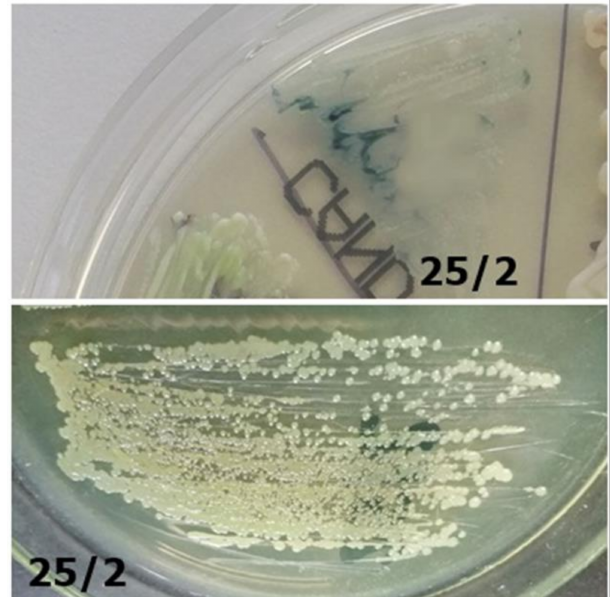
Figure 7. Strain 25/2-morphology on CHROMagar Candida and Sabouraud 2 with chloramphenicol medium (private collection).